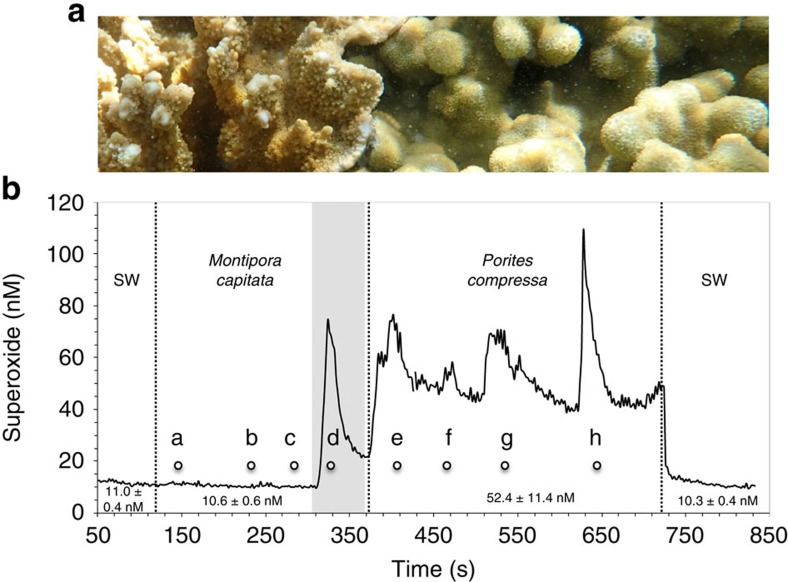
Superoxide concentrations across adjoining
M. capitata
and
P. compressa.(a) Close-up photo of adjoining M. capitata (left) and P. compressa (right). (b) Continuous superoxide measurements were made by moving the sample tubing across the coral surfaces, pausing for 20–60 s at the following positions: along the M. capitata surface at distances of (a) 10 cm, (b) 5 cm, (c) 1 cm and (d) <1 cm (shaded area) from the species interface; and along the P. compressa surface at distances of (e) <1 cm, (f) 1 cm, (g) 5 cm and (h) 10 cm away from the species interface. Chemiluminescence signals were converted to superoxide concentrations by first subtracting out signals of an aged filtered seawater baseline (not shown), and then corrected signals were converted to concentration using the daily calibration curve. The superoxide concentrations shown for the corals include both the coral-derived signal and the seawater (SW) signal (not SW corrected on the trace). Superoxide concentrations for M. capitata (averaged from a to c) and P. compressa (averaged from e to h) were significantly different (P=0.014) based on a two-sample t-test and are indicated below the superoxide trace, along with average superoxide levels in the background SW adjacent to each coral. On the basis of a two-sample t-test, superoxide levels at the M. capitata surface (a–c) were statistically similar (P>0.1) to the levels in the background SW, except right at the edge of the species interface (d, shaded area). Superoxide concentrations are reported as average±s.d. of the temporal signal.